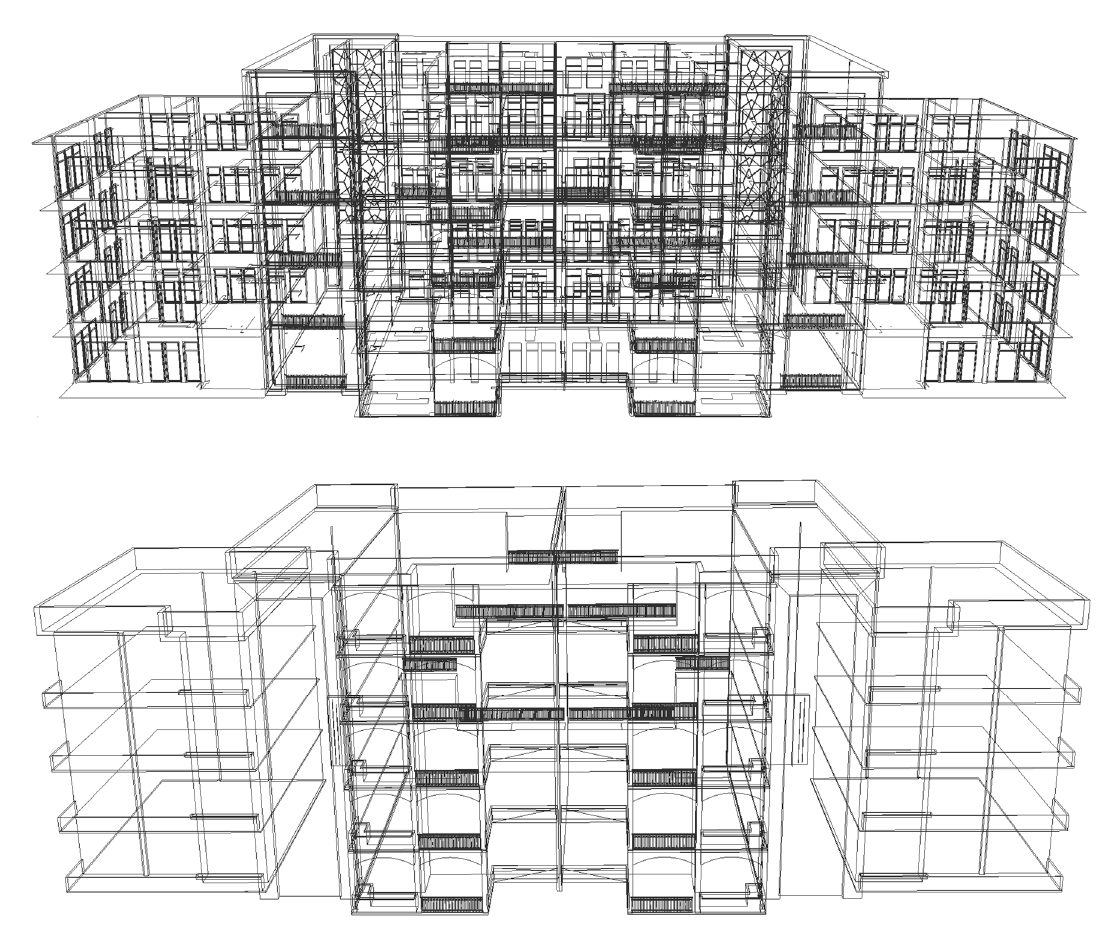
Figure 7. A non-optimized building model with 1,278,000 polygons ( left ) and an optimized building model with 24,000 polygons ( right ).